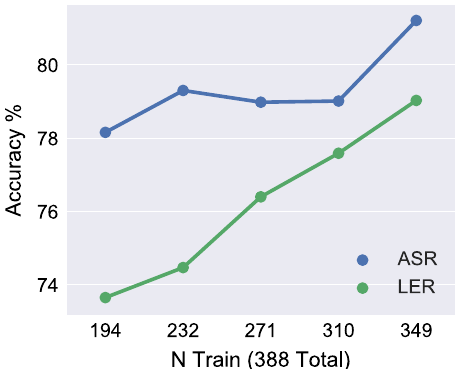
Fig. 3 Learning rate of ASR vs. LER for mobility classi fi cation. The x -axis is the number of GBs used in the training set, with the remaining GBs held out for validation. The accuracy was calculated over 25 independent fi ts. It appears that the LER accuracy increases slightly faster with more data, though a larger data set is necessary to con fi dently establish this point